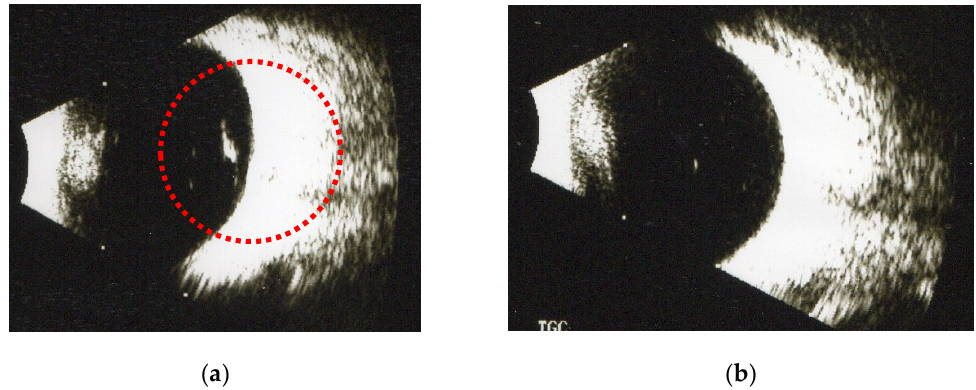
Figure 2. ( a ) One symptomatic vitreous opacity was found under B-scan before treatment. ( b ) The symptomatic vitreous opacity disappeared significantly as observed by ultrasound after 3 months of treatment with fruit collagenase supplements.